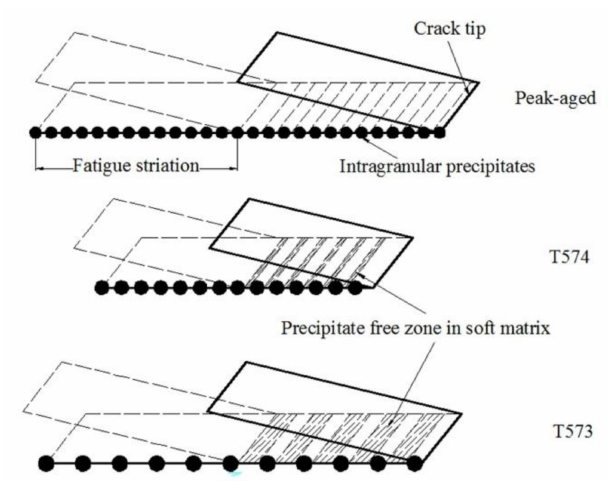
Figure 17. Schematic representation of precipitation characteristics a ff ecting fatigue crack growth in peak-aged and over-aged